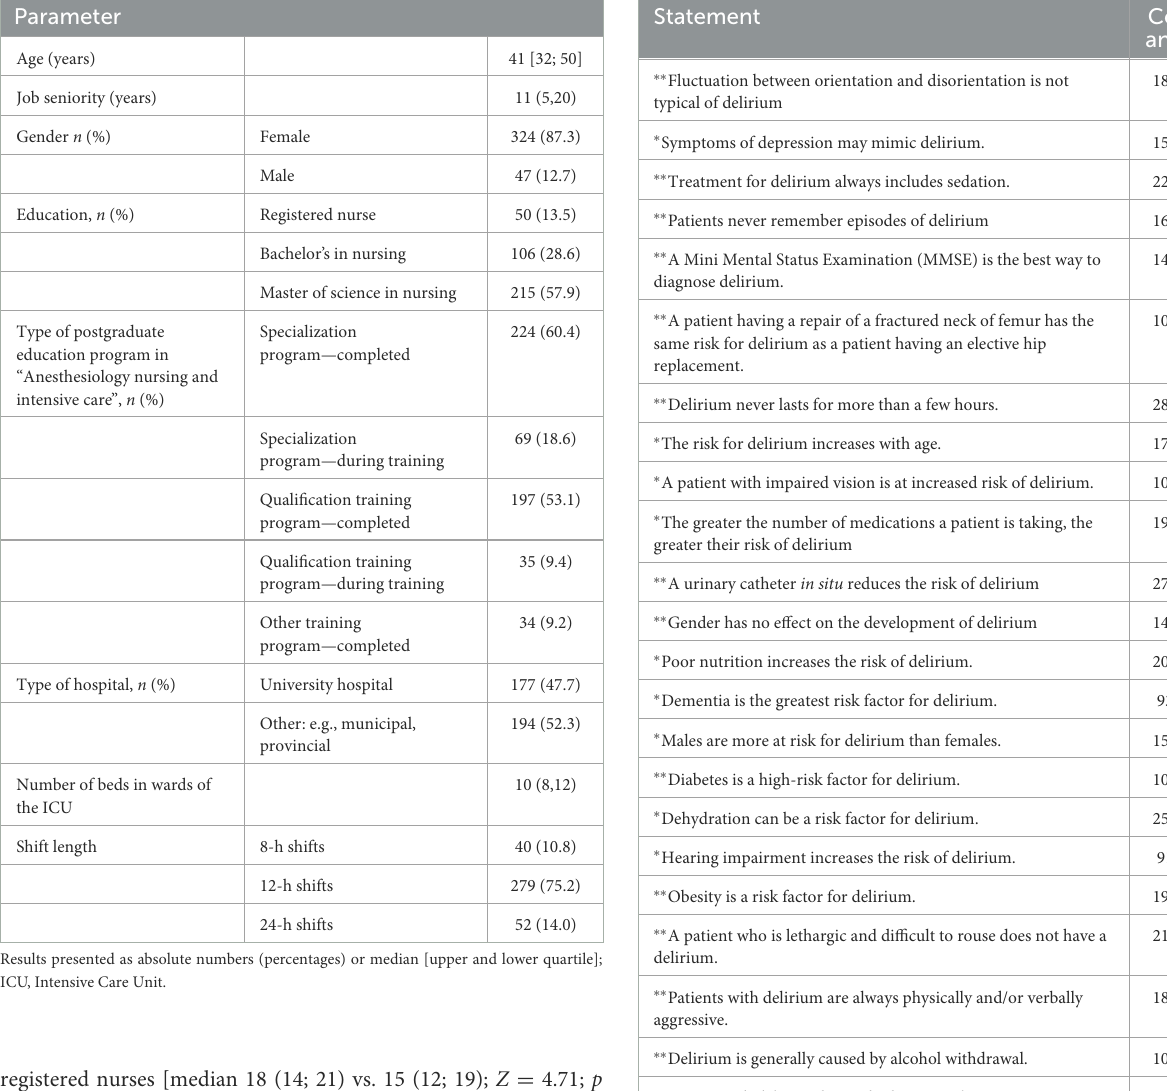
TABLE 1 Sociodemographic characteristics of subjects. TABLE 2 Nurses’ knowledge of